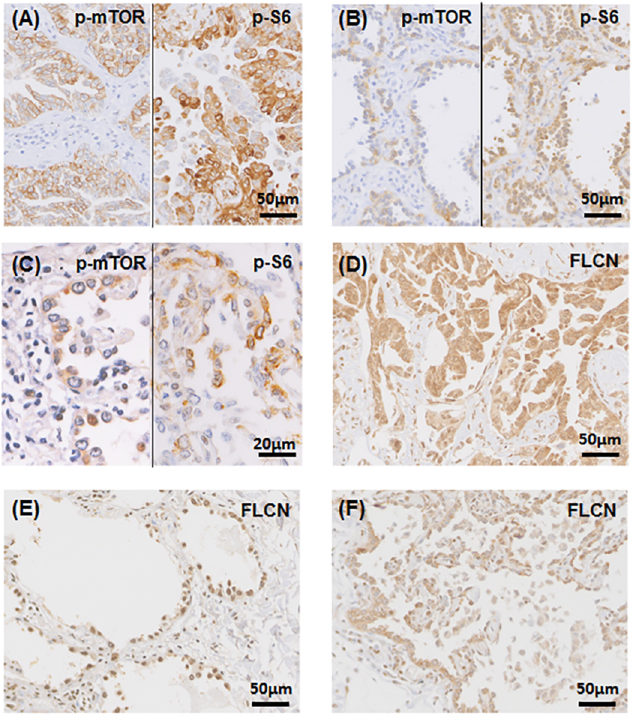
Fig 3. Expression of phospho-mTOR (p-mTOR), phospho-S6 (p-S6), and FLCN in BHD lung neoplasms. (A)-(C) The micropapillary adenocarcinoma (MPAC) (A), adenocarcinoma in situ (AIS) (B), and micronodular pneumocyte hyperplasia (MPH)-like lesion (C) show positive immunostaining for p-mTOR (left) and p-S6 (right). Lower p-mTOR and p-S6 staining intensities are observed in the MPH-like lesion compared to the adenocarcinomas. (D)-(F) The MPAC (D), AIS (E), and MPH-like lesion (F) are diffusely immunostained for FLCN